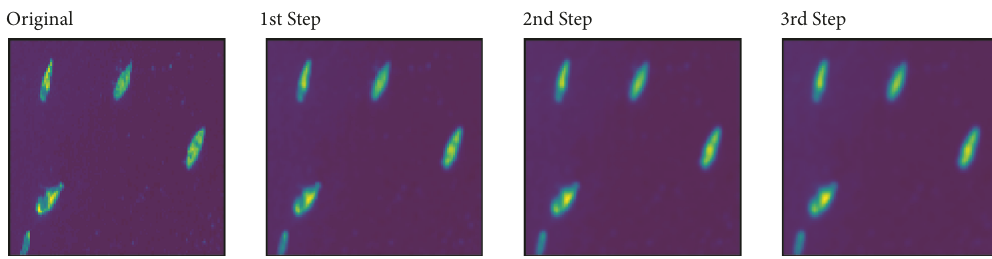
Figure 1: 3-step process on 5x5 kernels for noise